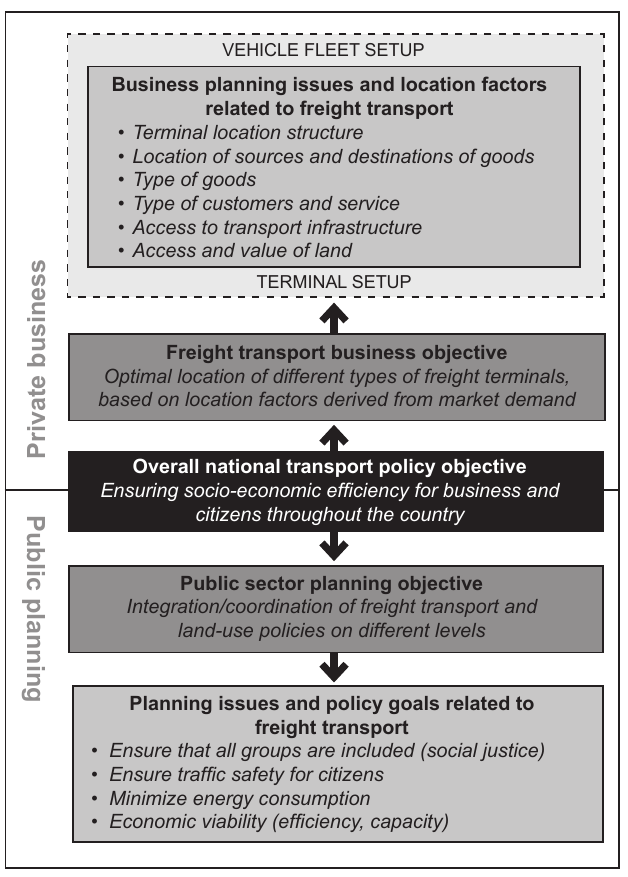
Figure 11: How the national transport policy objective can be implemented in the business and public planning